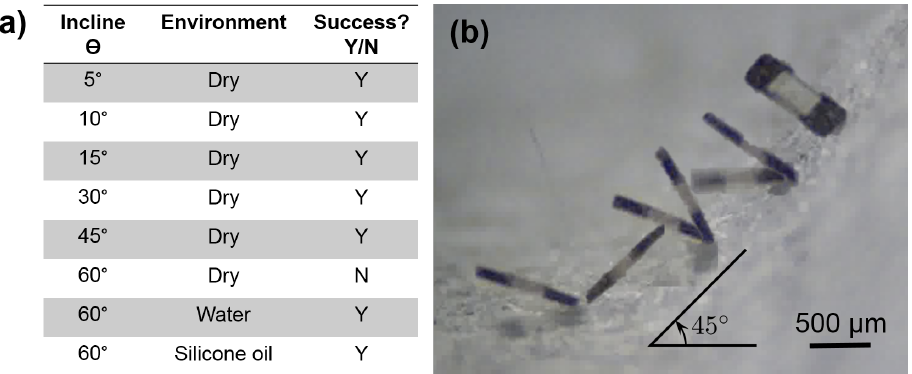
Figure 10. Inclined plane traversal tests. ( a ) Table of results for different inclination angles and environments; ( b ) images of the µ TUM traversing a 45 ◦ angle in dry conditions (10 mT field @ 0.5 Hz). Please see Supplemental Video S4 for video footage of these tests.